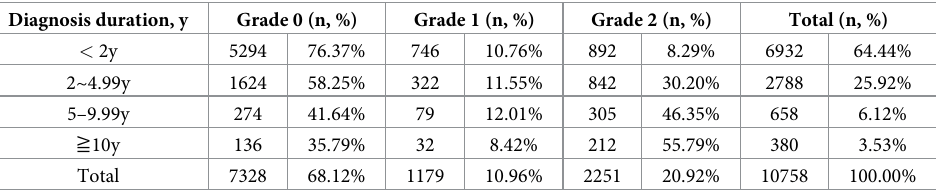
Table 5. Diagnosis Durations and Physical Disabilities Associated with Leprosy in Yunnan, China, 1990–2020. Diagnosis duration,